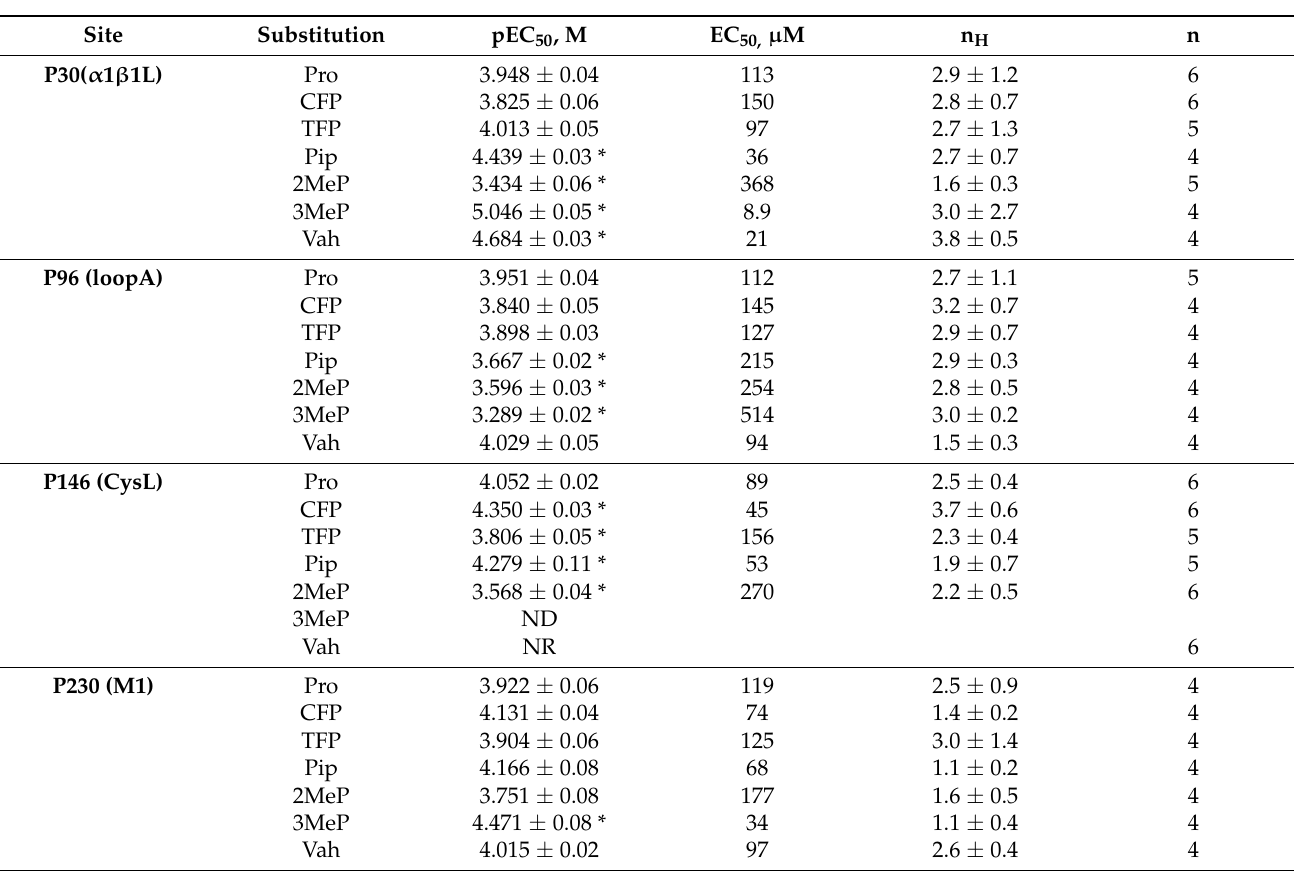
Figure 4. Concentration response curves for WT and mutant receptors T/G = I Tau /I max Gly . Data = mean ± SEM, n = 5. Parameters derived from these data are shown in Table 1. Table 2. Parameters derived from Pro ‐ substituted GlyR expressed in oocytes using nonsense sup ‐ pression.